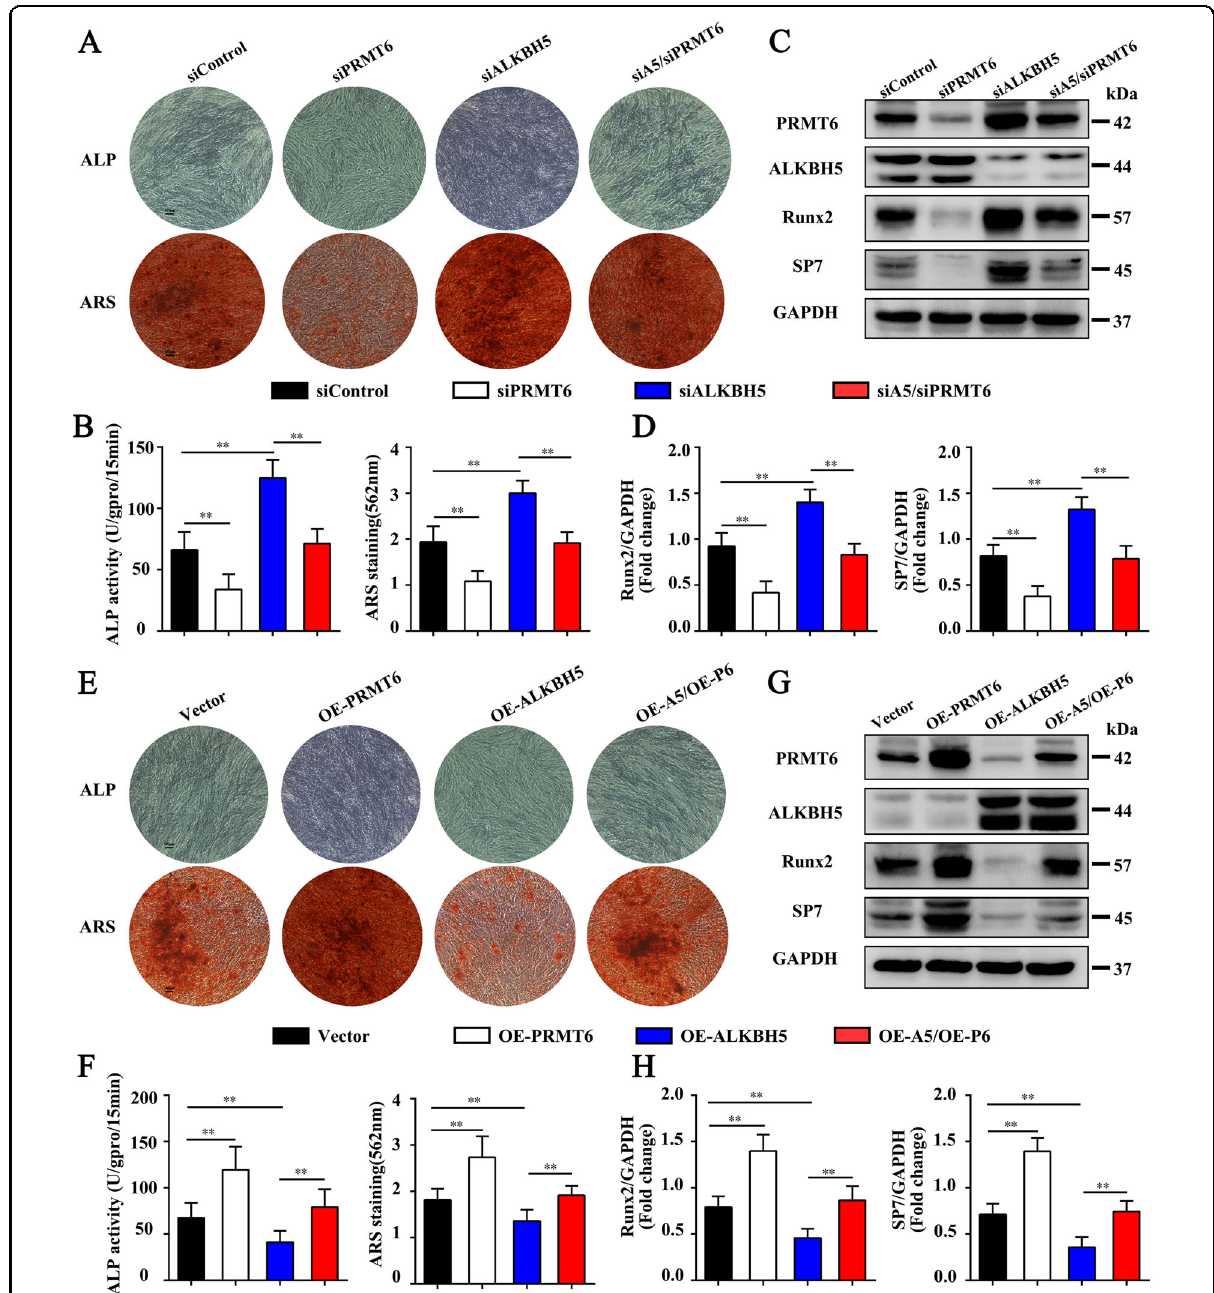
Fig. 6 ALKBH5 regulates the osteogenic differentiation ability of MSCs through PRMT6. A ALP staining and ARS staining after simultaneous interference with ALKBH5 and PRMT6 expression. Scale bar, 100 µm. B ALP activity and ARS staining quanti fi cation after simultaneous interference with ALKBH5 and PRMT6 expression ( n = 3 independent experiments with three different MSC lines). C , D Protein levels of the osteogenesis- associated markers RUNX2 and SP7 were determined by western blot analysis ( n = 3 independent experiments with three different MSC lines). E ALP staining and ARS staining after overexpression of ALKBH5 and PRMT6. Scale bar, 100 µm. F ALP activity and ARS staining quanti fi cation after overexpression of ALKBH5 and PRMT6 ( n = 3 independent experiments with three different MSC lines). G , H Western blot detection of RUNX2 and SP7 expression after overexpression of ALKBH5 and PRMT6 ( n = 3 independent experiments with three different MSC lines). All data are presented as the means ± SDs. ** p <